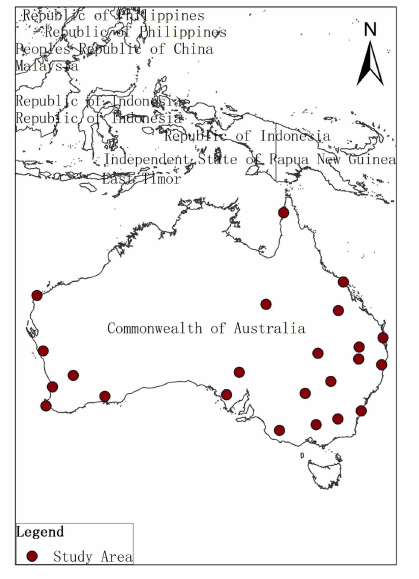
Figure 1 . Location diagram of the study